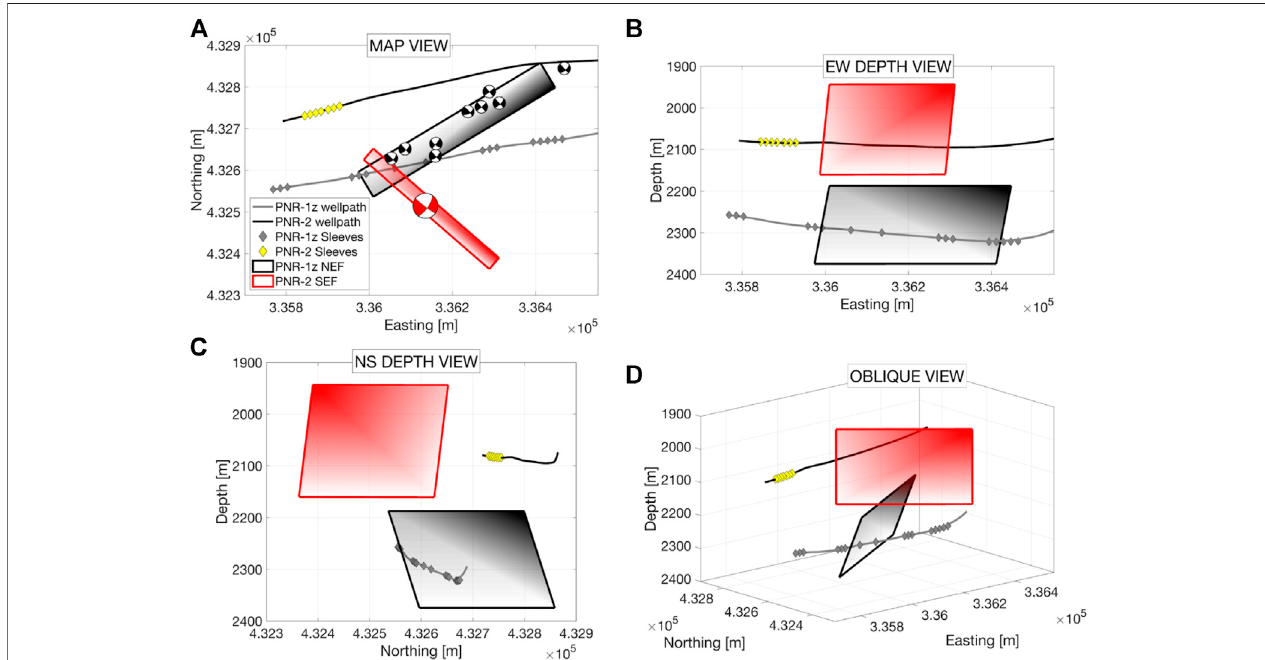
FIGURE2| LocationsandorientationsofthetwofaultzonesactivatedduringhydraulicfracturingoperationsatPrestonNewRoad.ThePNR-1zNEfault,shownby the black plane, was identifed from the locations and FMs of the largest events to occur during PNR-1z operations in 2018 (Clarke et al., 2019a), which are shown as black lower hemisphere beach balls in (A) , a map view. The PNR-2 SE fault (shown by the red plane) was constrained from the FM of the ML 2.9 event, shown as a red beach ballin (A) , as well asthe hypocenters ofits microseismic aftershocks (see Kettlety et al., 2021, Figure6). Shadingacross the planes shown here attempts to aid visualization of the fault orientations in 3-dimensions (B) and (C)